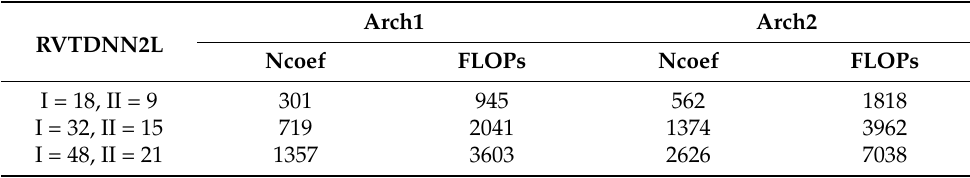
Table 6. Performance and complexity of different RVTDNN2L DPD models.